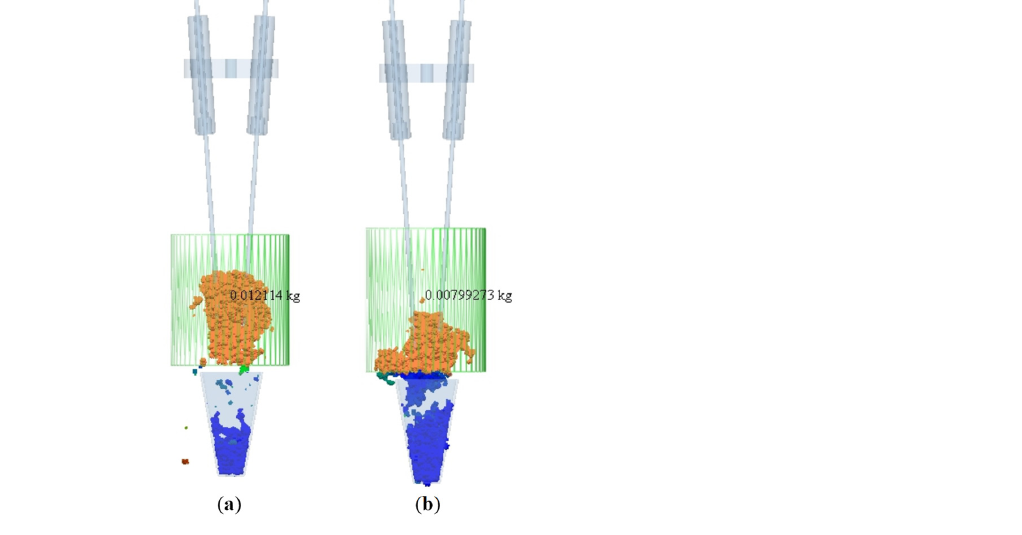
Figure 6. Comparison of different seedling substrate integrity: ( a ) is a relatively intact substrate and ( b ) is a broken seedling substrate.